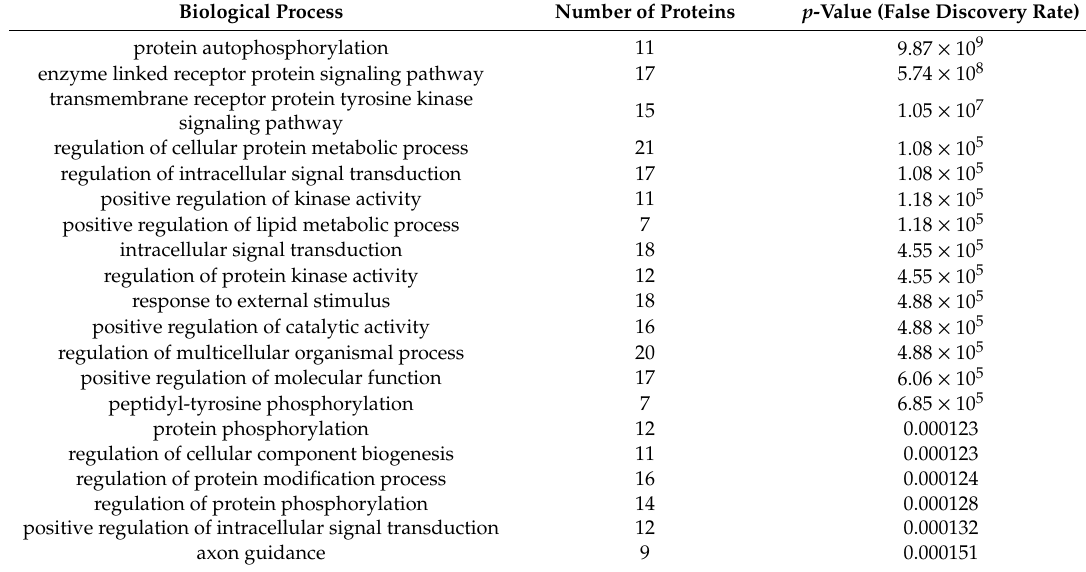
Table 6. Top 20 GO biological processes enriched from unique peptides in the postbiotic plus C. perfringens challenge jejunum (compared to postbiotic and C. perfringens challenge